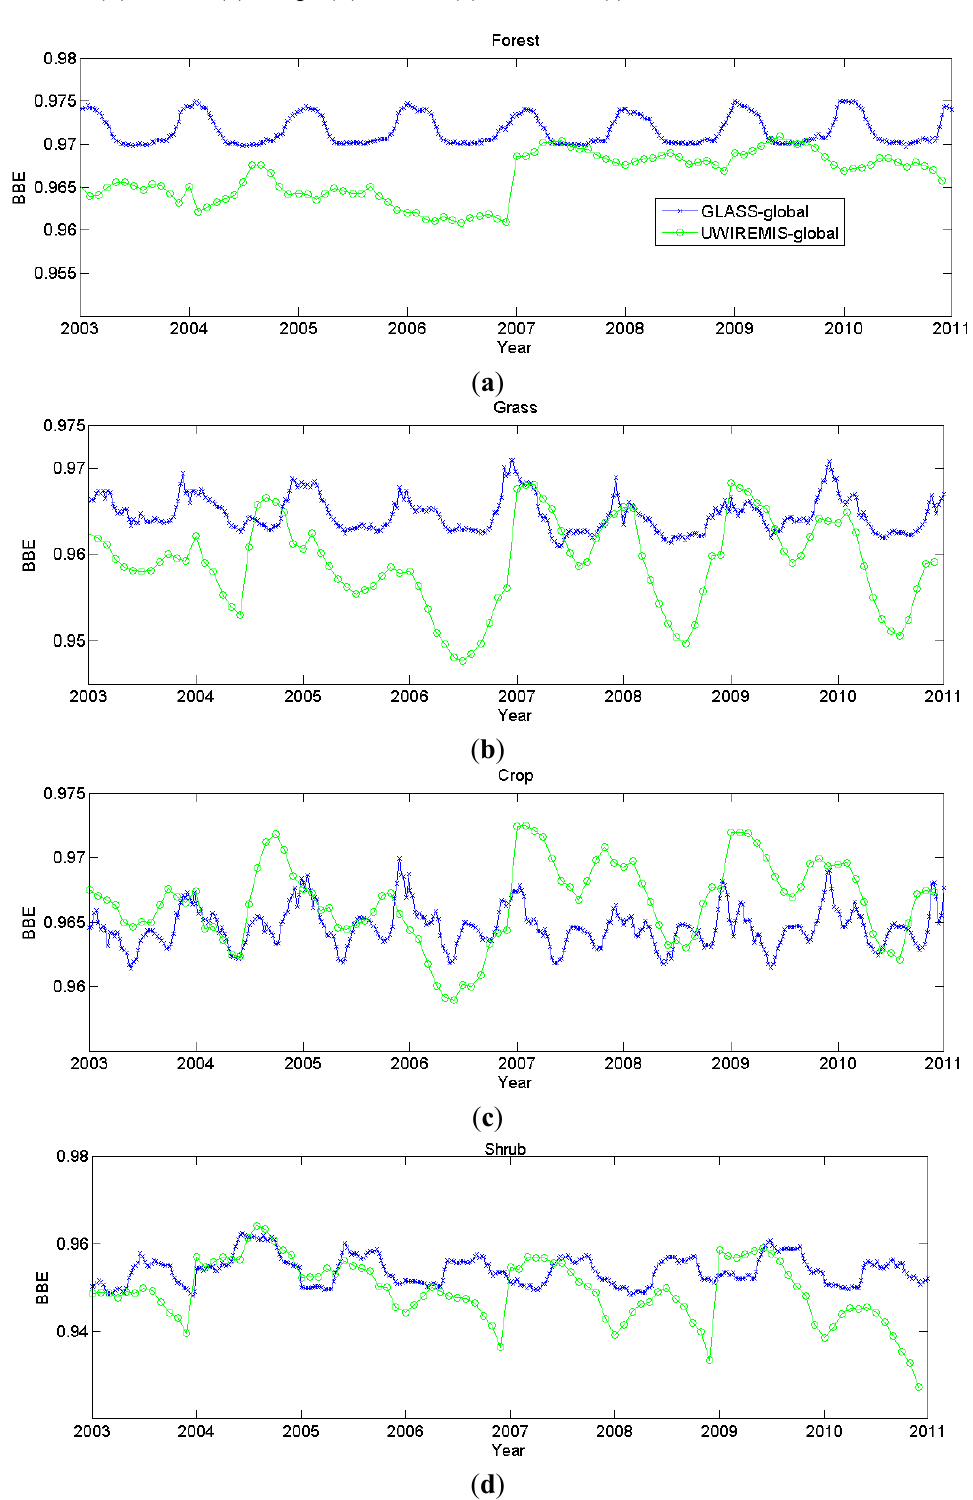
Figure 10. Time series of mean GLASS BBE and UWIREMIS BBE from years